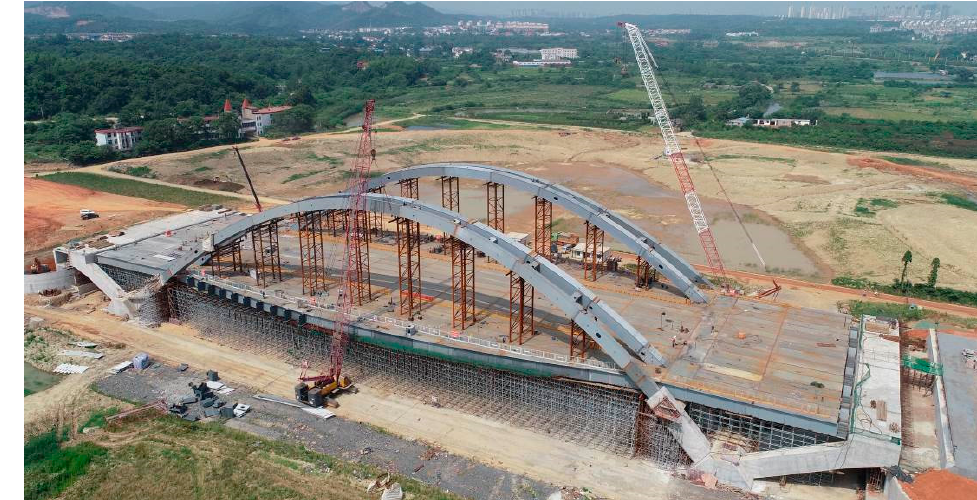
Figure 3. Cross-section of the bridge (unit: mm).